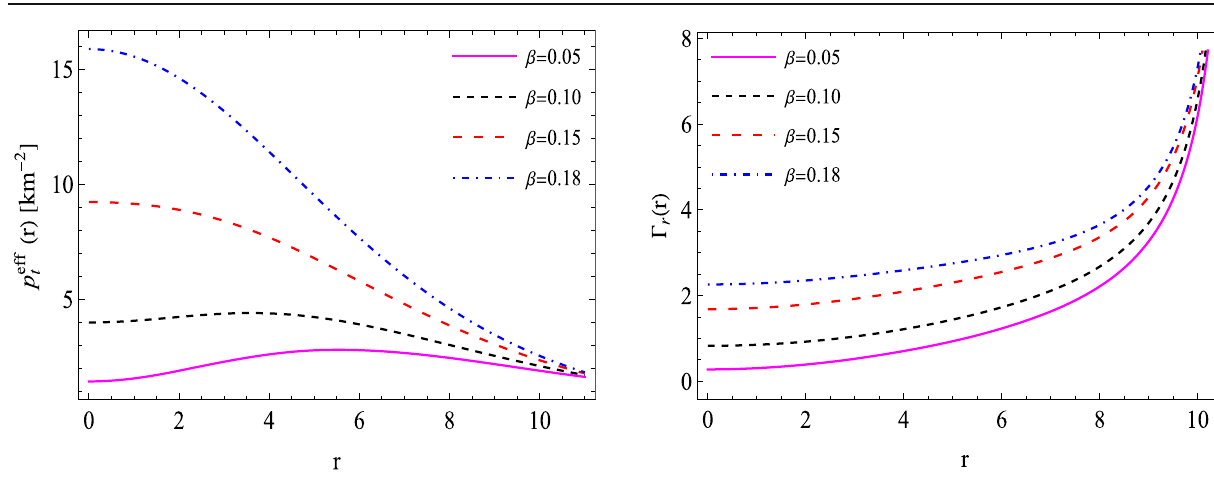
Fig. 6, and their corresponding central values are shown in Table 1 for all chosen values of β . It is noteworthy to note